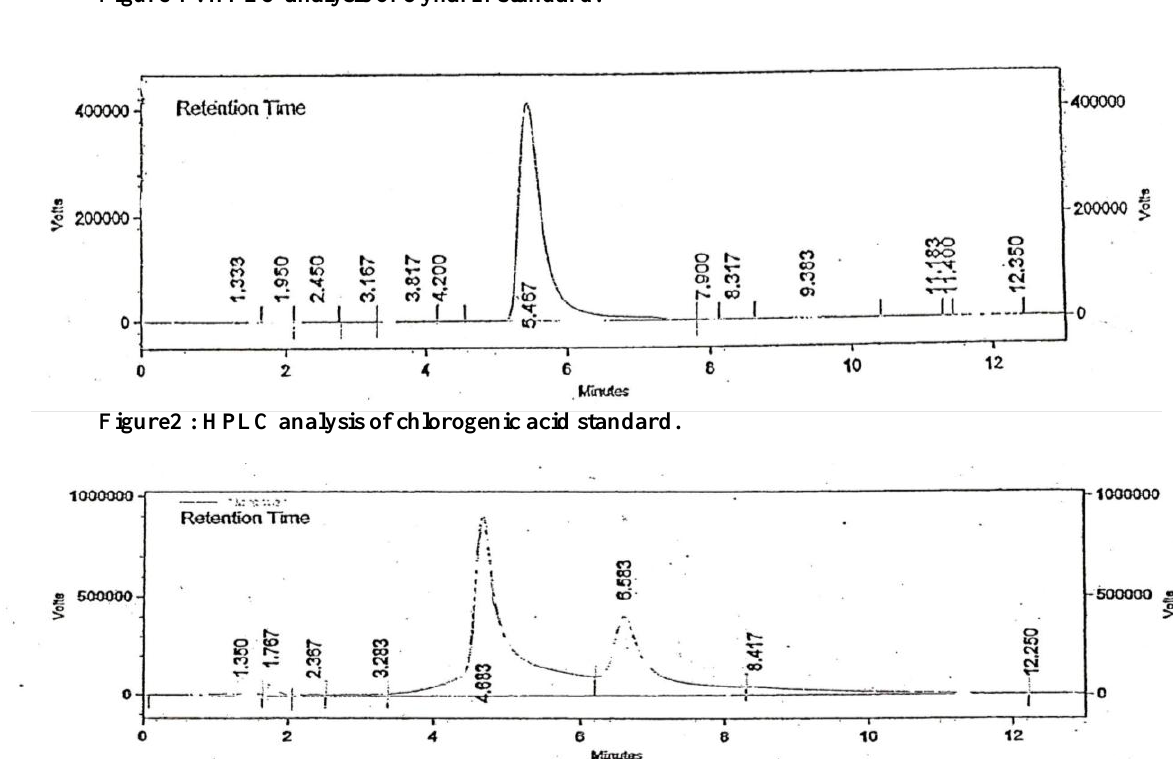
Figure 3: HPLC analysis ofmixture of cynarin and chlorogenic acid